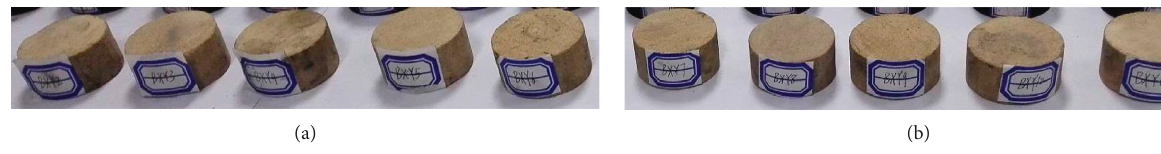
Figure 2: Diagram of the rock specimens.